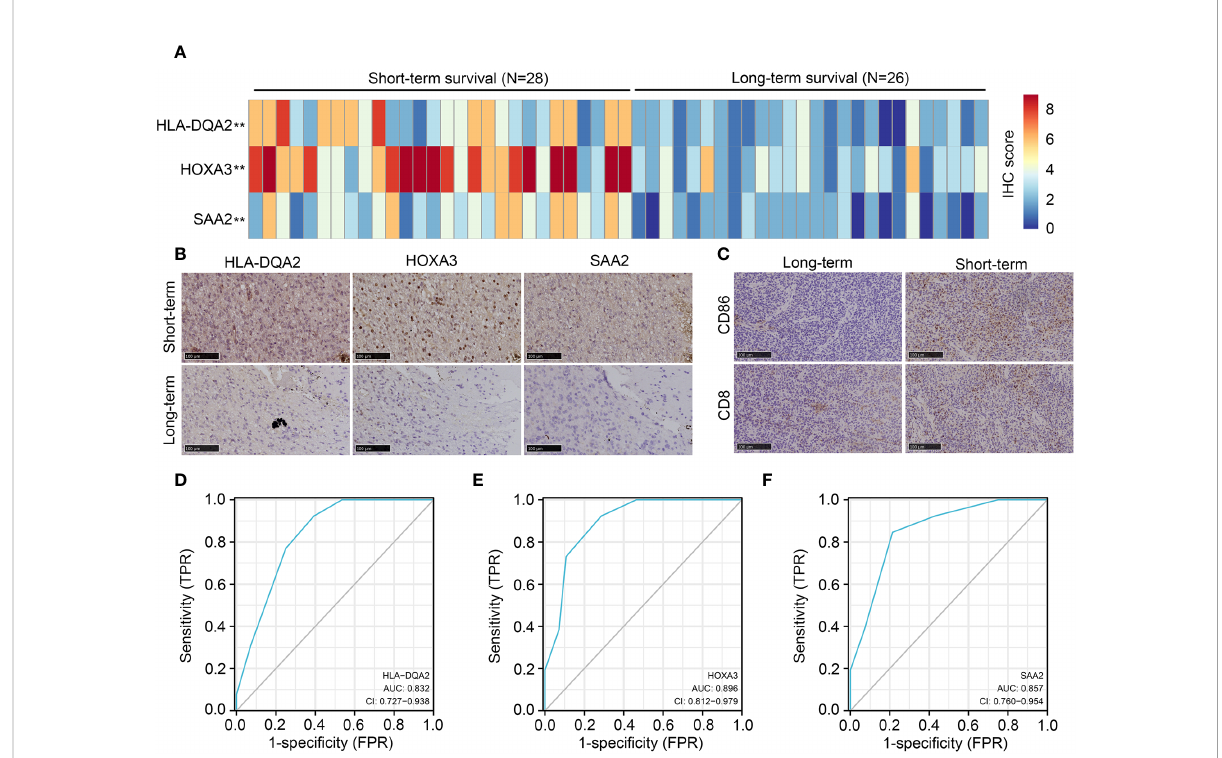
FIGURE 10 Expression of HLA-DQA2 , HOXA3 , SAA2 , CD86 , and CD8 in IDH1mt-glioma tissues. IDH1mt-glioma tissues were divided into long- and short- term survival groups according to the patient ’ s number of days of survival with the cut-off as 15 months. (A) The IHC score of HLA-DQA2 , HOXA3 , and SAA2 in IDH1mt-glioma tissues in long- and short-term groups. (B) Representative fi gures of expression of HLA-DQA2 , HOXA3 , and SAA2 in long- and short-term group IDH1mt-glioma tissues. (C) Expression of CD86 and CD8 in long- and short-term group IDH1mt-glioma tissues. (D – F) The diagnostic value of HLA-DQA2 , HOXA3 , and SAA2 for distinguishing long- and short-term survival of IDH1mt-glioma patients. ** P < 0.01.